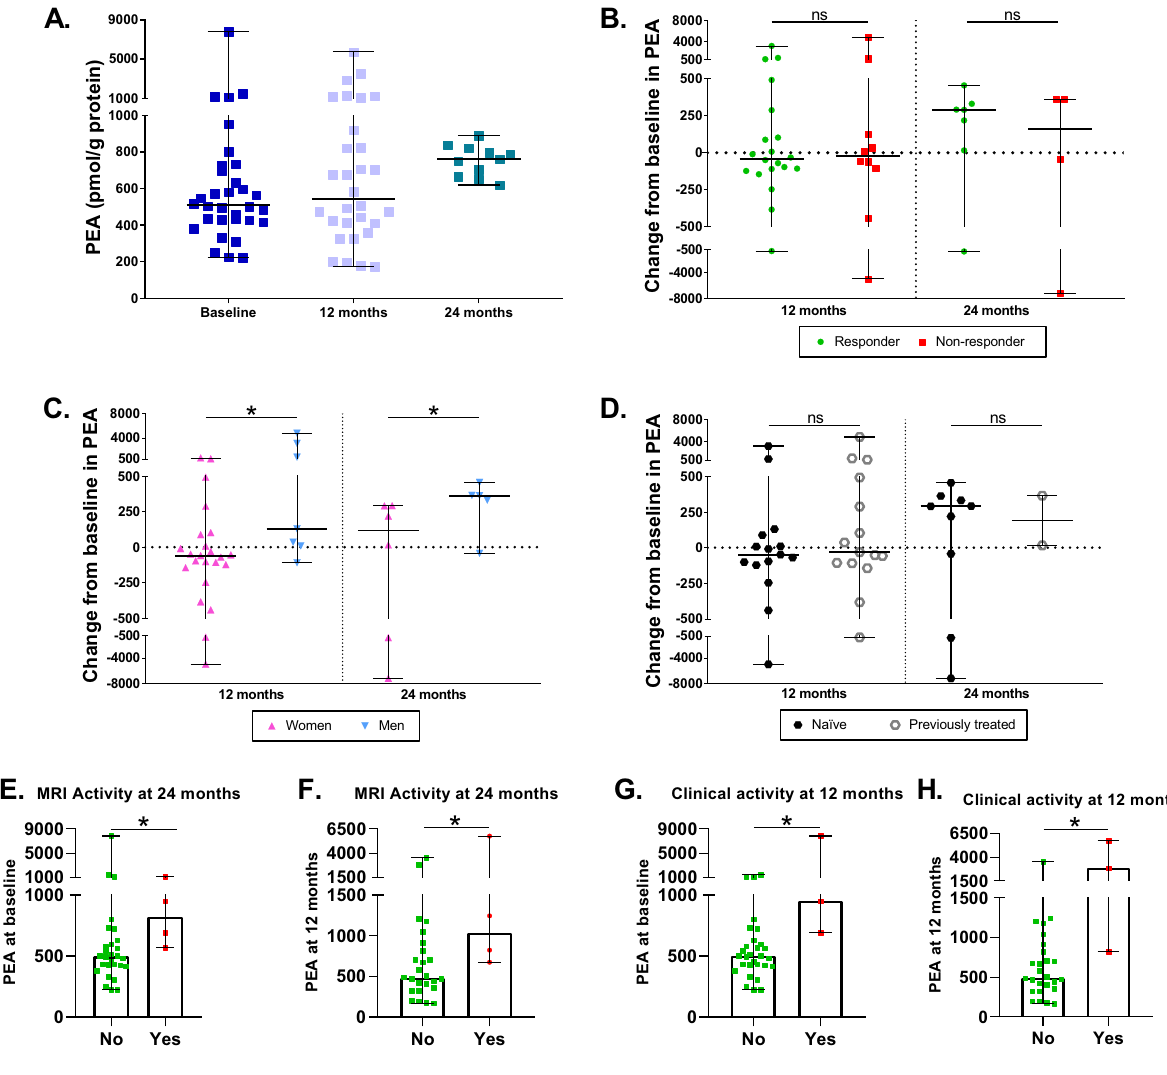
Figure 5. Characterization of PEA levels during DMF treatment. ( A ) PEA levels in MS patients at baseline and after 12 and 24 months of DMF treatment. ( B ) Changes in PEA levels at 12 and 24 months compared to baseline between responders and non-responders to DMF. ( C ) Changes in PEA levels at 12 and 24 months compared to baseline between women and men. ( D ) Changes in PEA levels at 12 and 24 months compared to baseline between naïve and previously treated patients. ( E ) PEA at baseline in patients with (yes) or without (no) MRI activity at 24 months. ( F ) PEA at 12 months in patients with (yes) or without (no) MRI activity at 24 months. ( G ) PEA at baseline in patients with (yes) or without (no) clinical activity at 12 months ( H ) PEA at 12 months in patients with (yes) or without (no) clinical activity at 12 months. The Wilcoxon test was used to compare differences between the different time points and baseline, and the Mann–Whitney test was used to compared differences between subgroups. Data are expressed as median with range. *p < 0.05; ns, not